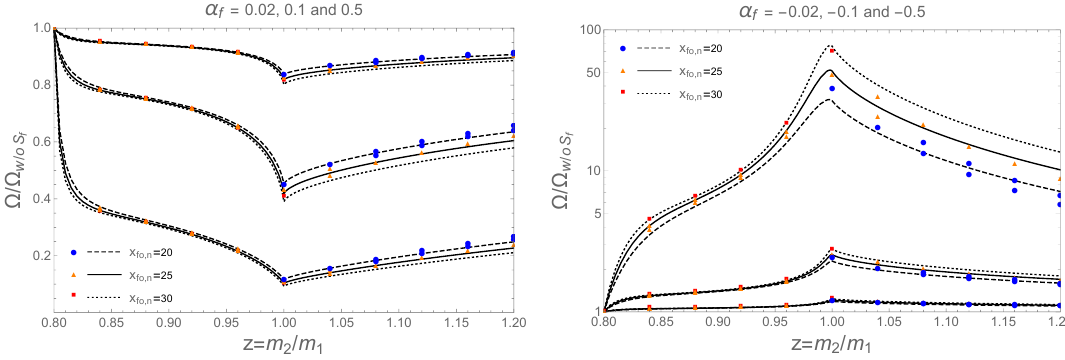
Figure 2 . The ratio of DM relic densities with and without the FSS effect computed from eq. (2.14), as a function of the mass ratio of the final and initial state particles. The dashed, solid and dotted lines are for the representative freeze-out values of x fo , n = 20 , 25 and 30 , respectively, without the FSS effect. The three groups of lines from top to bottom are for α f = 0 . 02 , 0 . 1 and 0 . 5 in the left panel, while they are for − 0 . 5 , − 0 . 1 and − 0 . 02 in the right panel. Also plotted are ratios calculated directly from eq. (2.7), using three sets of ( a 0 / GeV − 2 , m 1 / GeV) = (10 − 9 , 10 3 ) , (10 − 9 , 10 4 ) , (10 − 7 , 10 4 ) , and g 1 = 2 . According to whether the freeze-out, without including